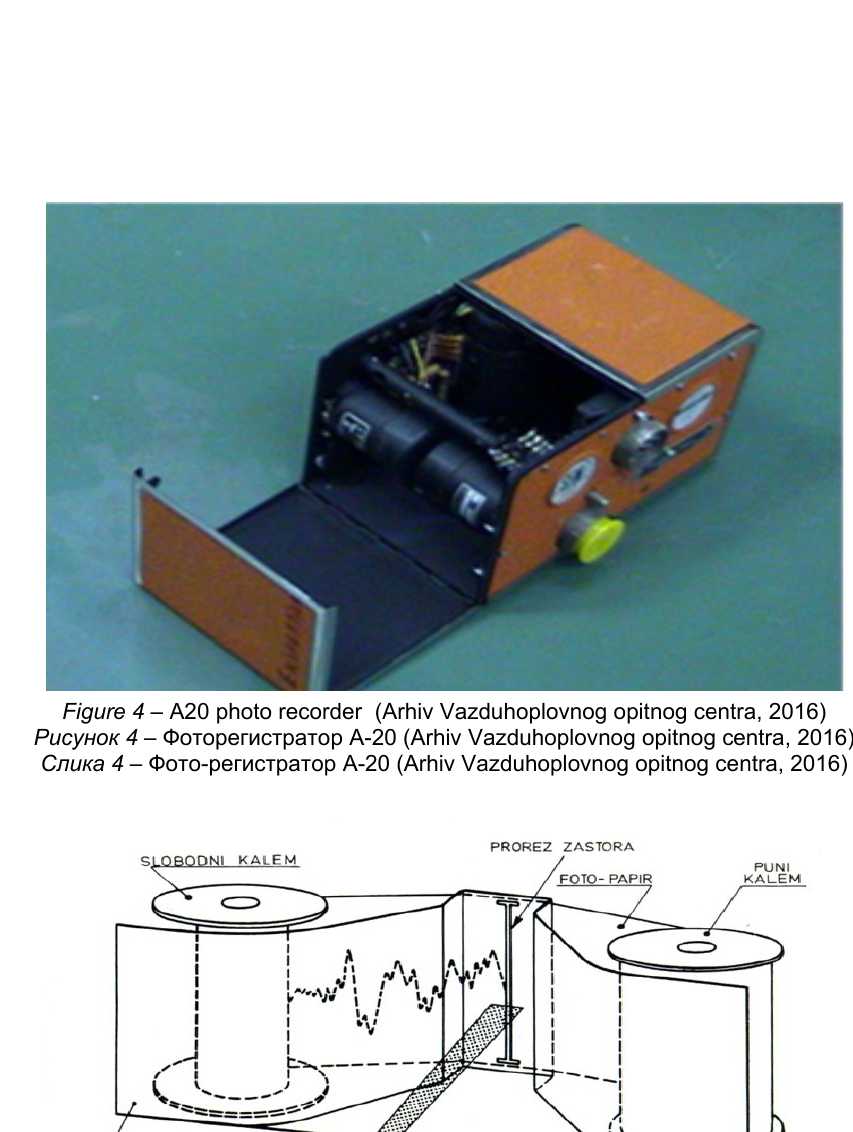
Figure 4a – The principle of A 20 photo recorders Рисунок 4 а – Принцип работы фоторегистратора A 20 Слика 4 а – Принцип рада фото - регистратора А